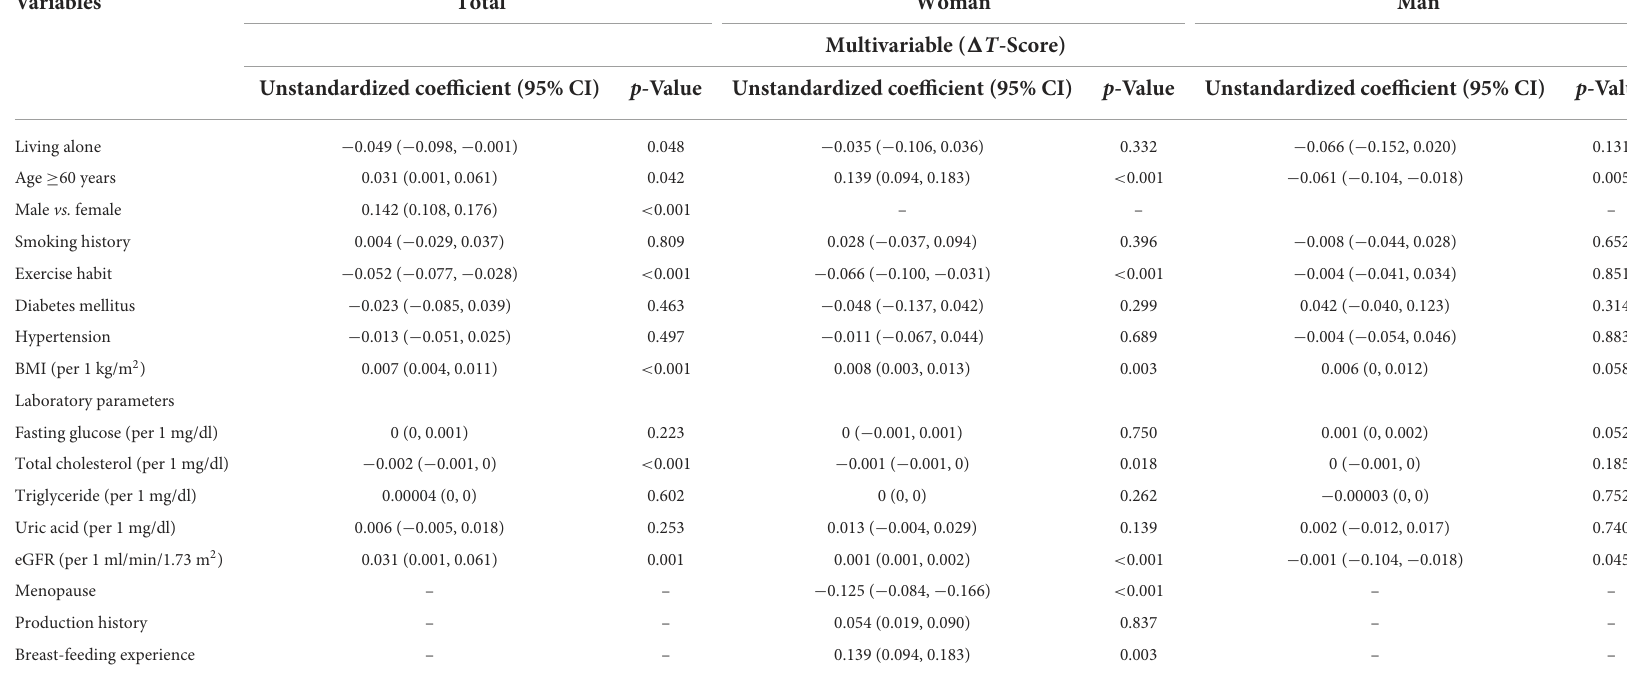
TABLE 4 Association of living condition and calcaneus ultrasound 1 T -score in study participants ( n = 26,850) using multivariable linear regression analysis. Variables